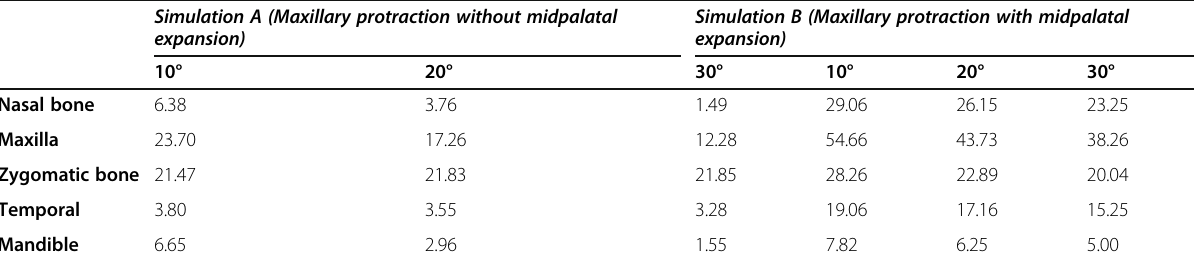
Table 4 Maximum Von Mises stresses in the maxillofacial structures when 250-g force was applied at three different angulations in two clinical simulations (A & B) (in